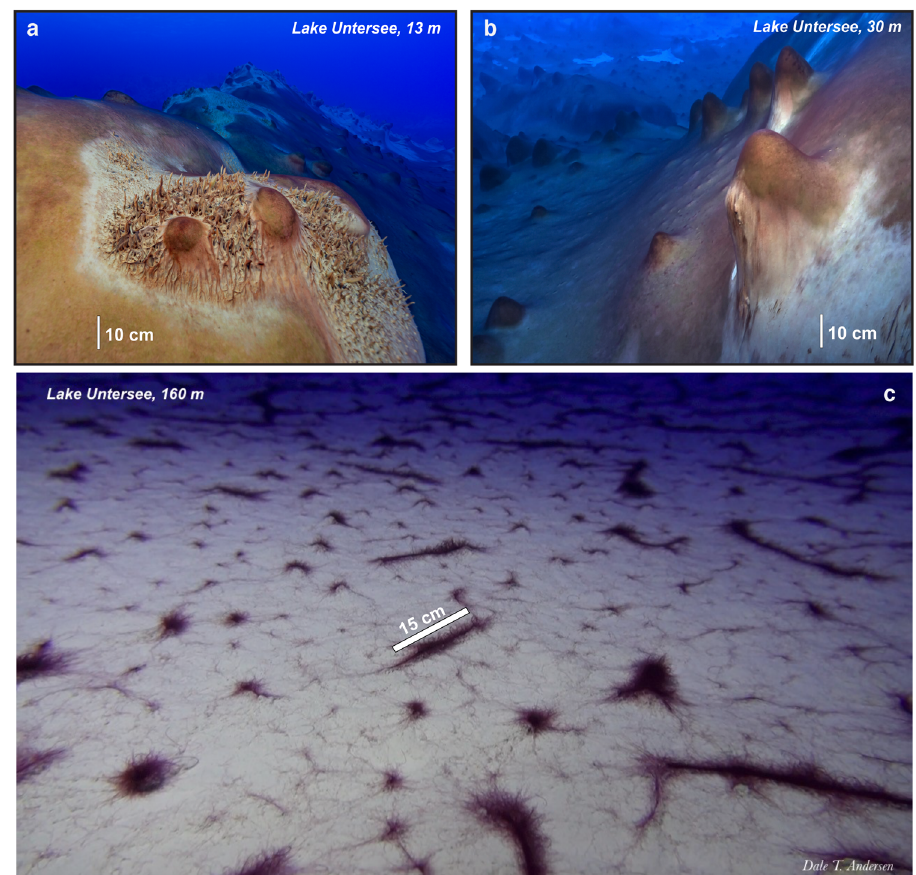
Fig. 2 Benthic microbial ecosystem in Lake Untersee, Antarctica. Photographs of laminated microbial mats, cones and pinnacles growing in Lake Untersee. a , b Photos of mats at 12 – 13 m and c. 30 m depth near the sampling location of mats. c Photo of mats at 160 m depth. Note the water column ’ s clarity, re fl ecting the nutrient-starved water — photos taken by co-author D.